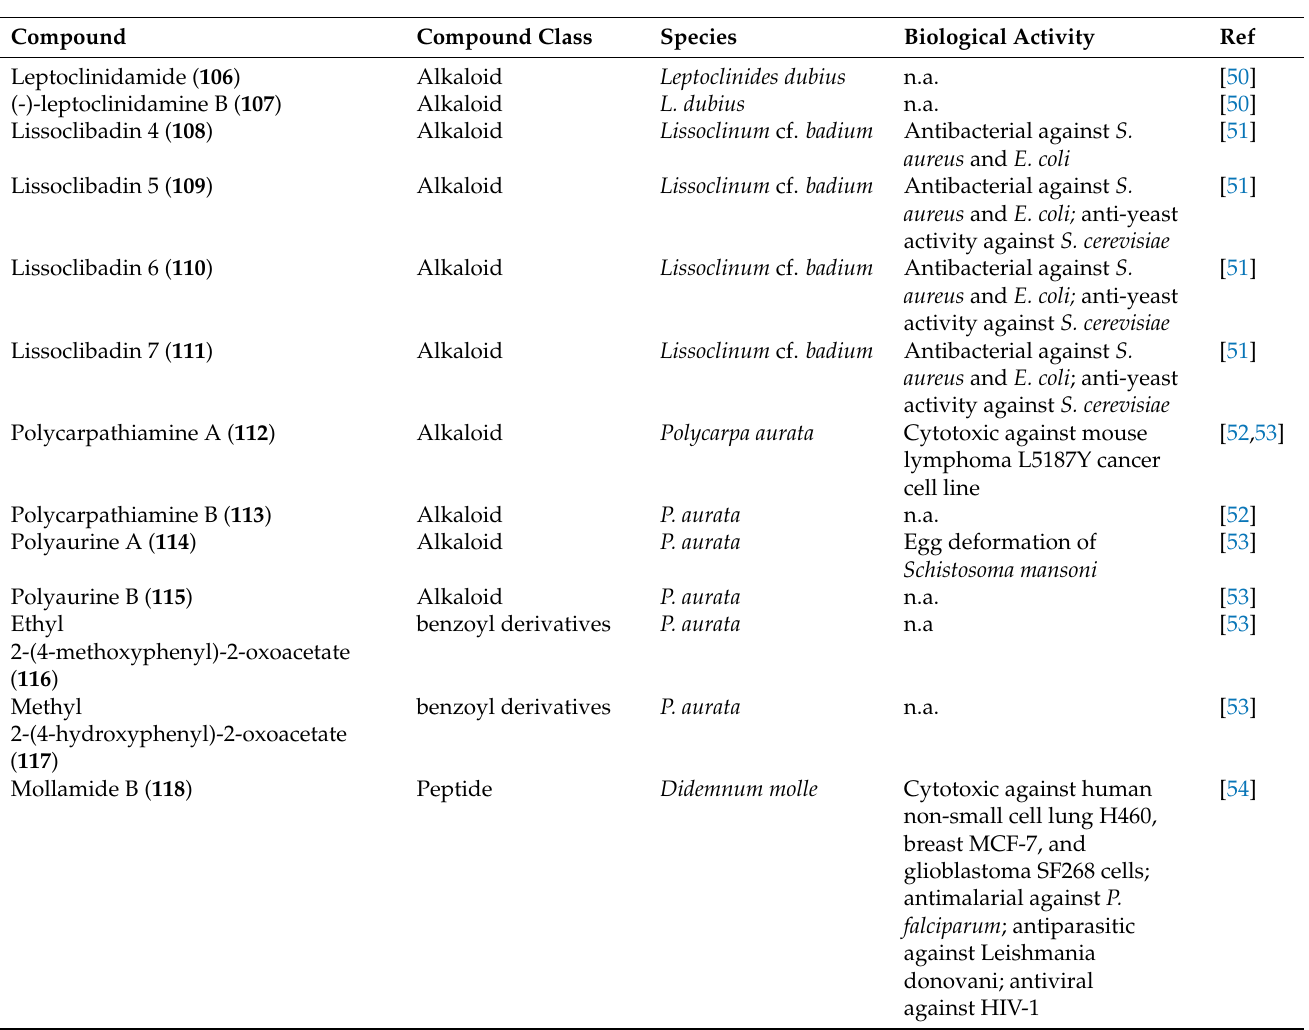
Table 2. Summary of the marine natural products isolated from the marine tunicates from Indonesian oceans.